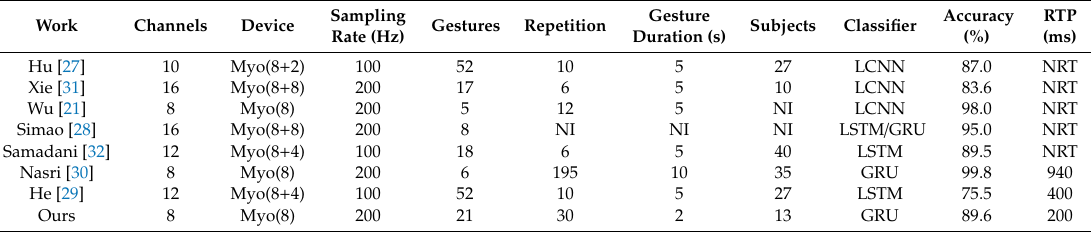
Table 3. Comparison with state-of-the-art using